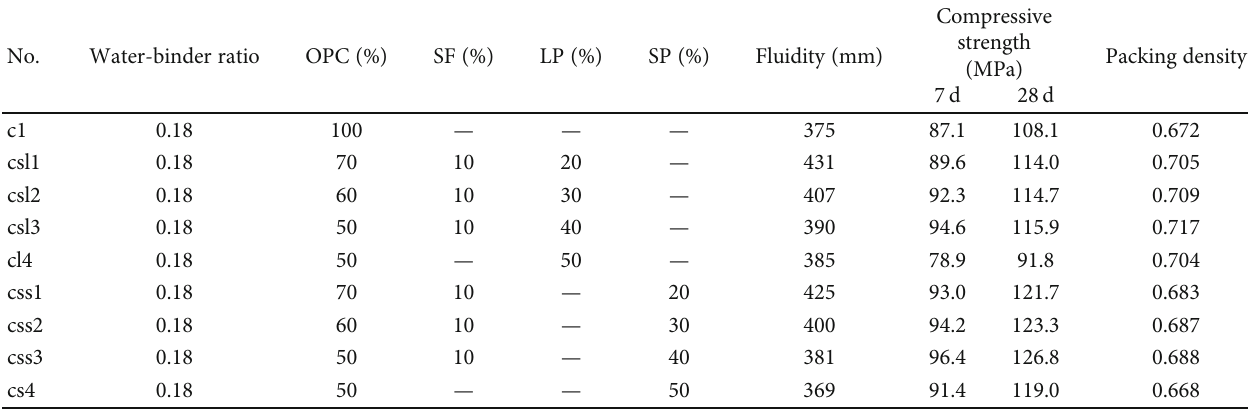
Table 2: Test results for packing density, fl uidity, and compressive